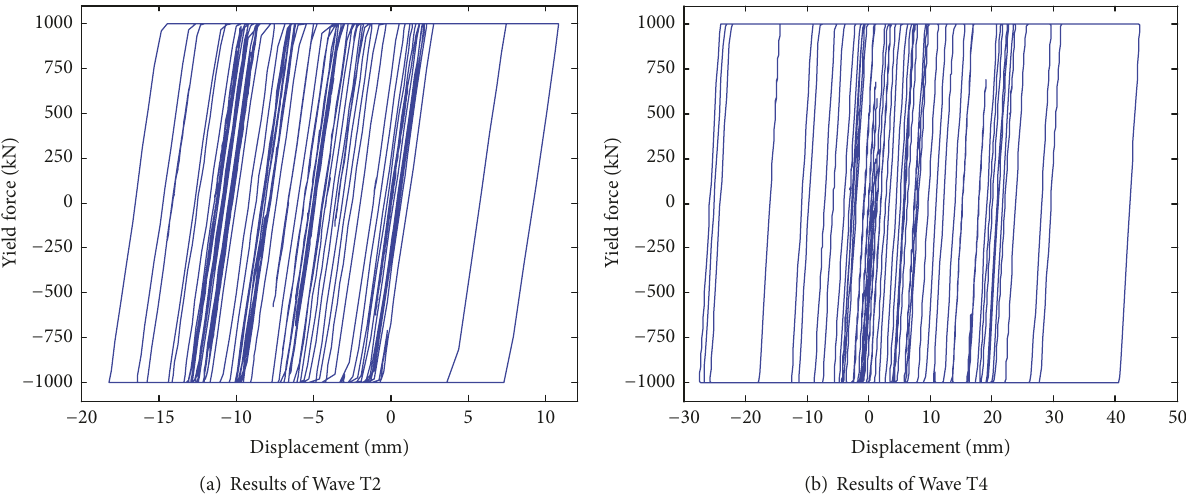
Figure 26: Hysteretic curves of ILSD-LS of different ground